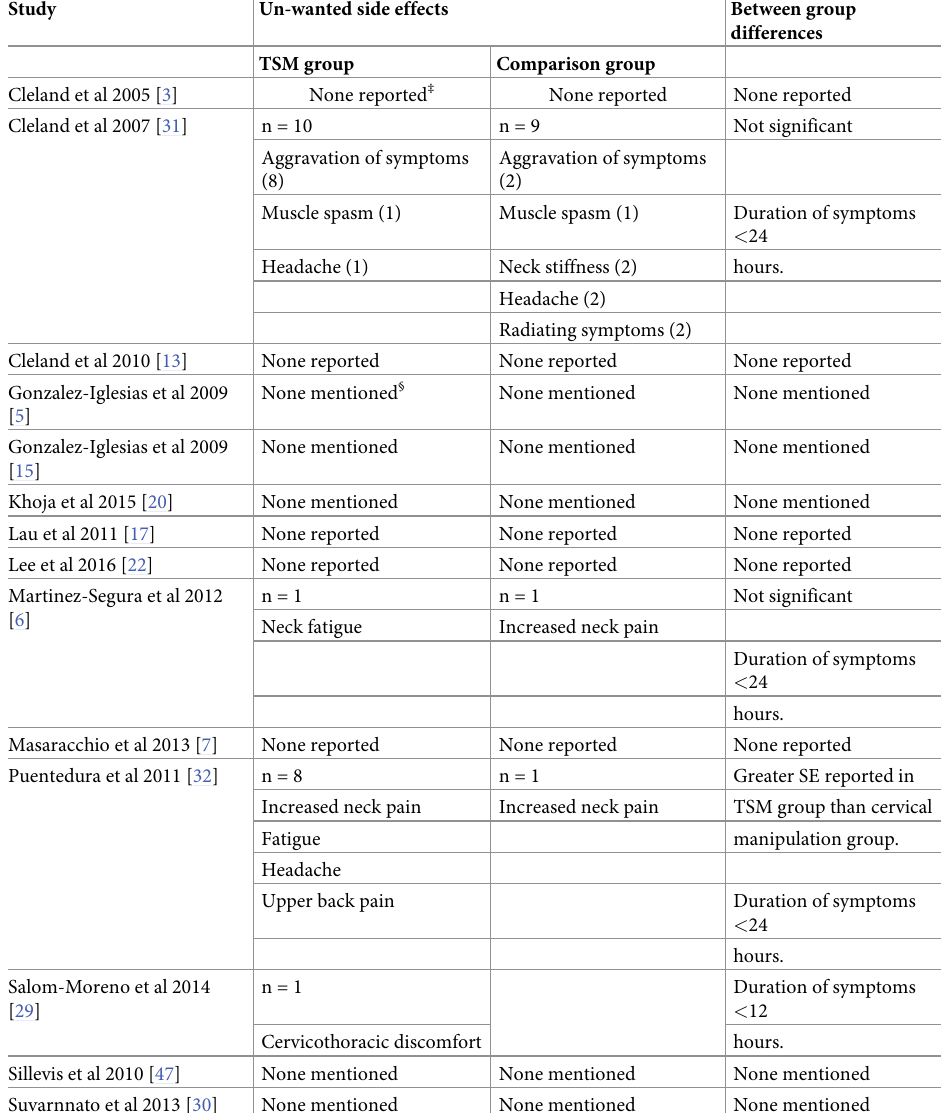
Table 5. Adverse events � and un-wanted side effects † reported in included